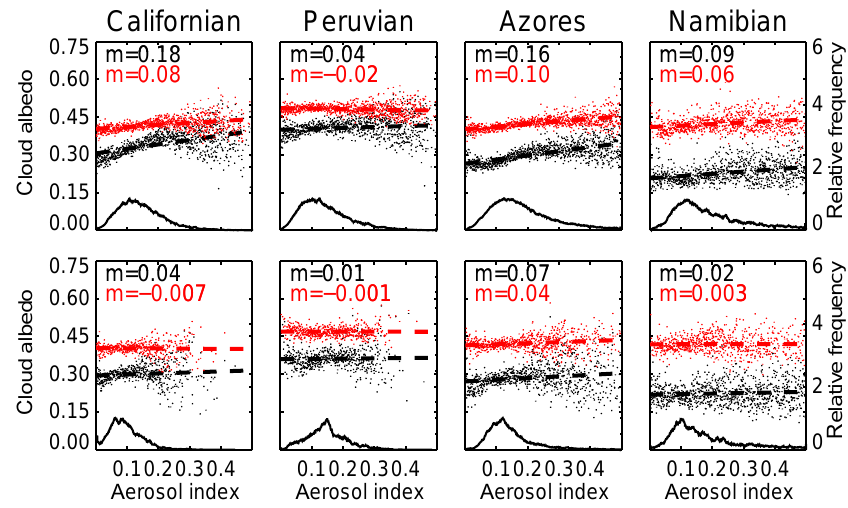
Figure 6. Same as Fig. 5 but for additional regions including Peru (10–20 ◦ S, 80–90 ◦ W), the Azores (15–25 ◦ N, 25–35 ◦ W), and Namibia (10–20 ◦ S, 0–10 ◦